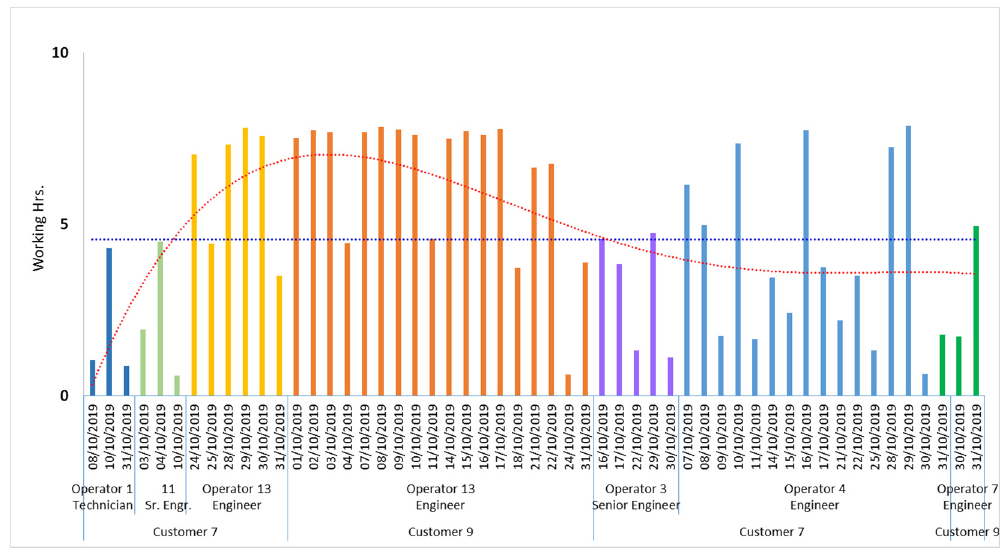
Figure 11. Product type Camera—October 2019.